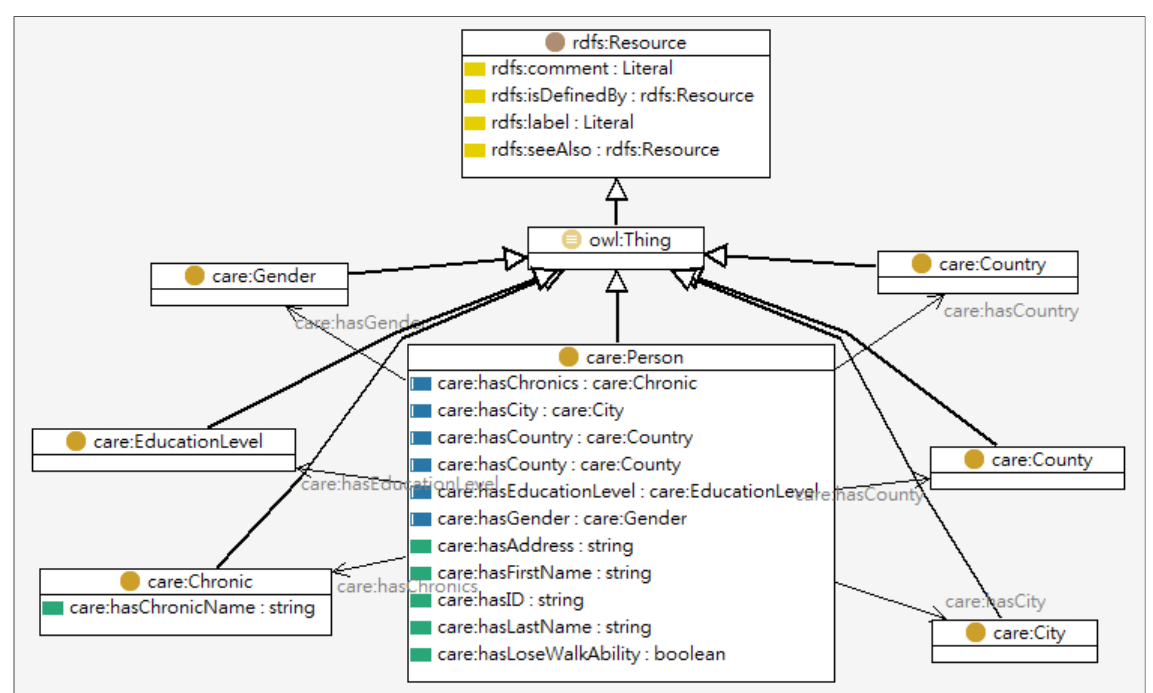
Figure 3. Partial model of user profile